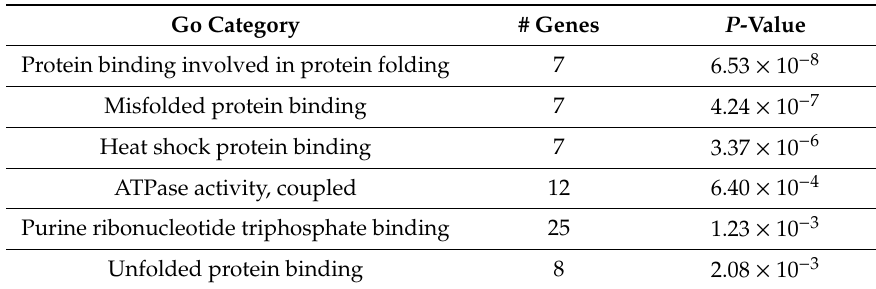
Table 2. Gene ontology (GO) category enrichment for soluble proteins that are overrepresented in sua5 relative to WT (Fold-change sua5 / WT > 1.3) - Function.